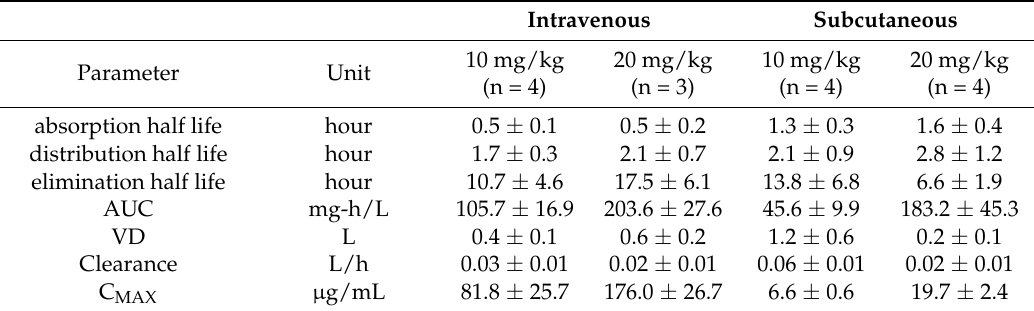
Intravenous Subcutaneous 10 mg/kg